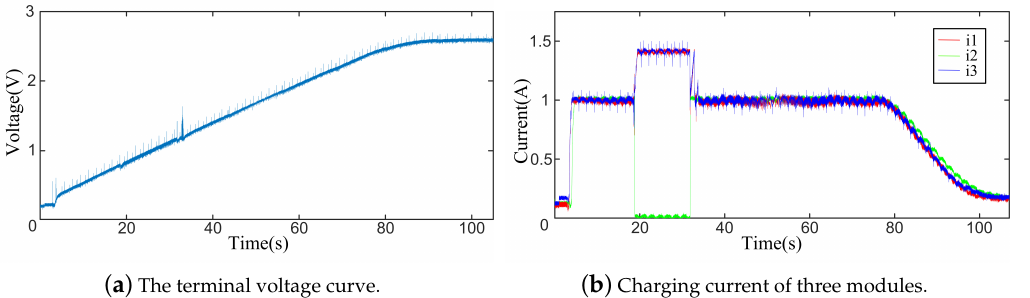
Figure 10. Fault-tolerant Charging